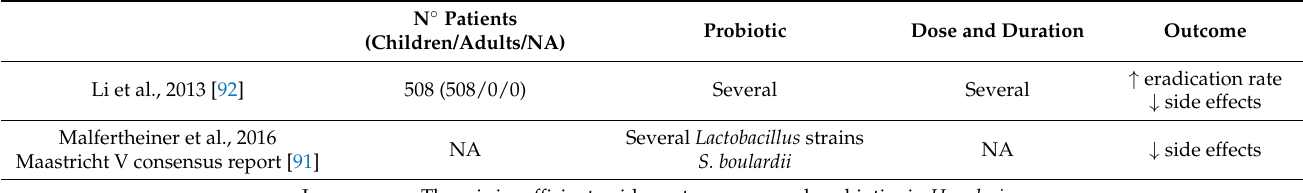
Table 12. Meta-analysis and systematic review on probiotics in H. pylori